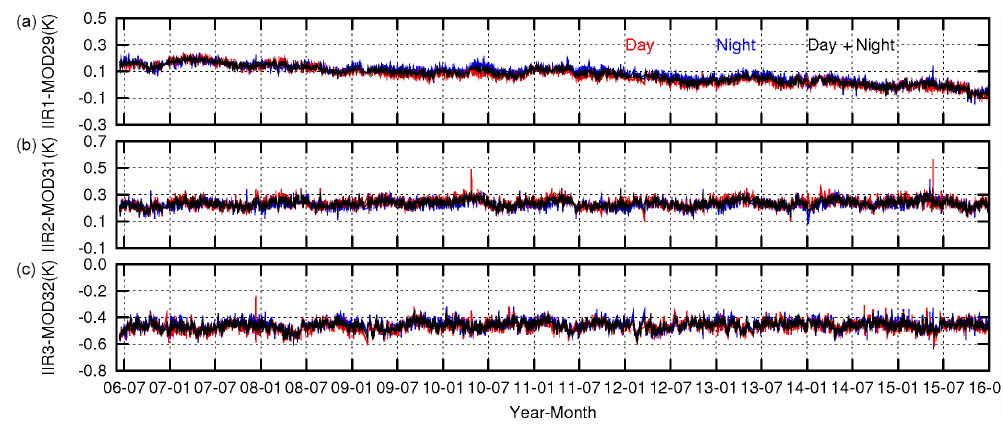
Figure 12. Same as Fig. 11, but at 60–30 ◦ S.